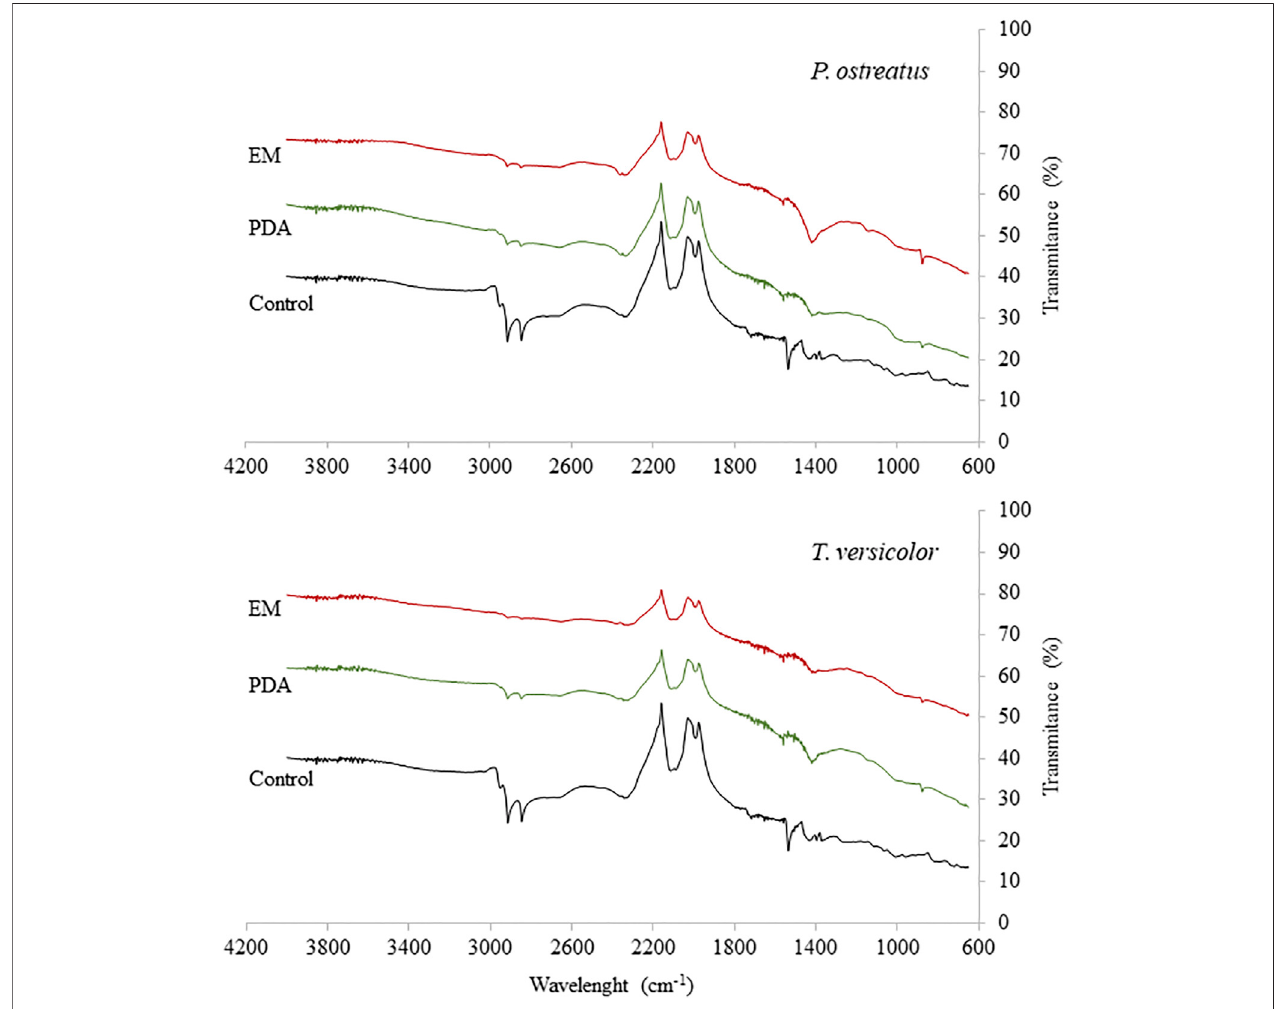
FIGURE 2 | FTIR spectrum of vulcanised rubber particles after incubation with Trametes versicolor and Pleurotus ostreatus using PDA and EM medium.